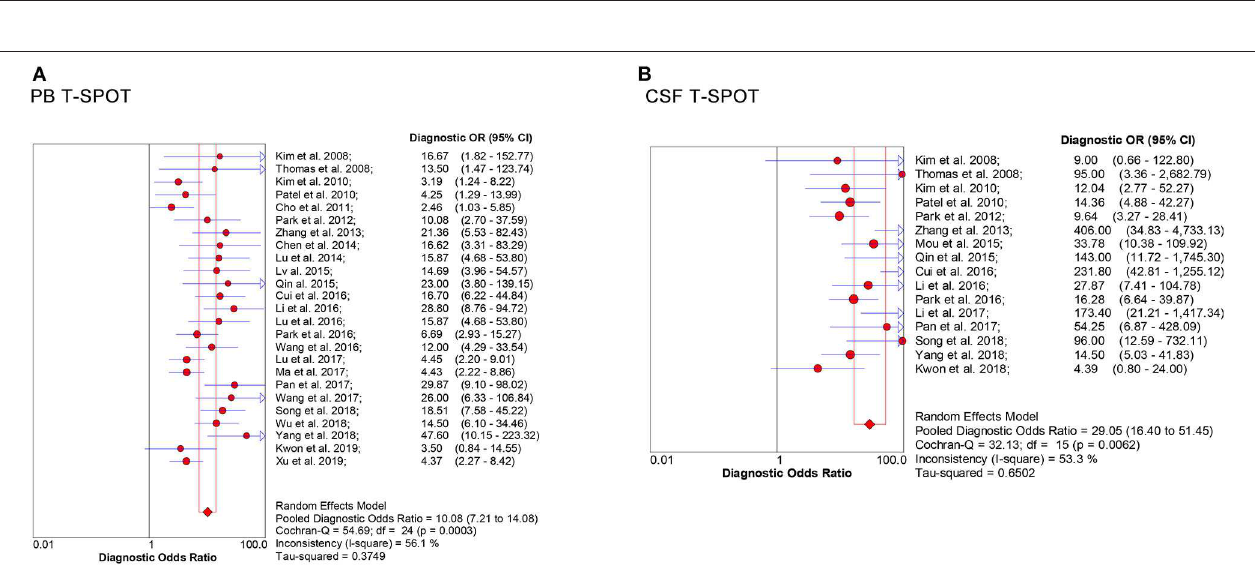
FIGURE 4 | Forest plot showing estimates of sensitivity, specificity, PLR, and NLR for CSF T-SPOT for the diagnosis of TBM. Solid dots represent the point estimates of sensitivity, specificity, PLR, and NLR from each study. Size of solid dots reflects the total number of cases and controls. Error bars indicate 95% CI. Pooled results are shown as diamonds. PLR, positive likelihood ratio; NLR, negative likelihood ratio; CSF, cerebrospinal fluid; TBM, tuberculous meningitis; CI, confidence interval.